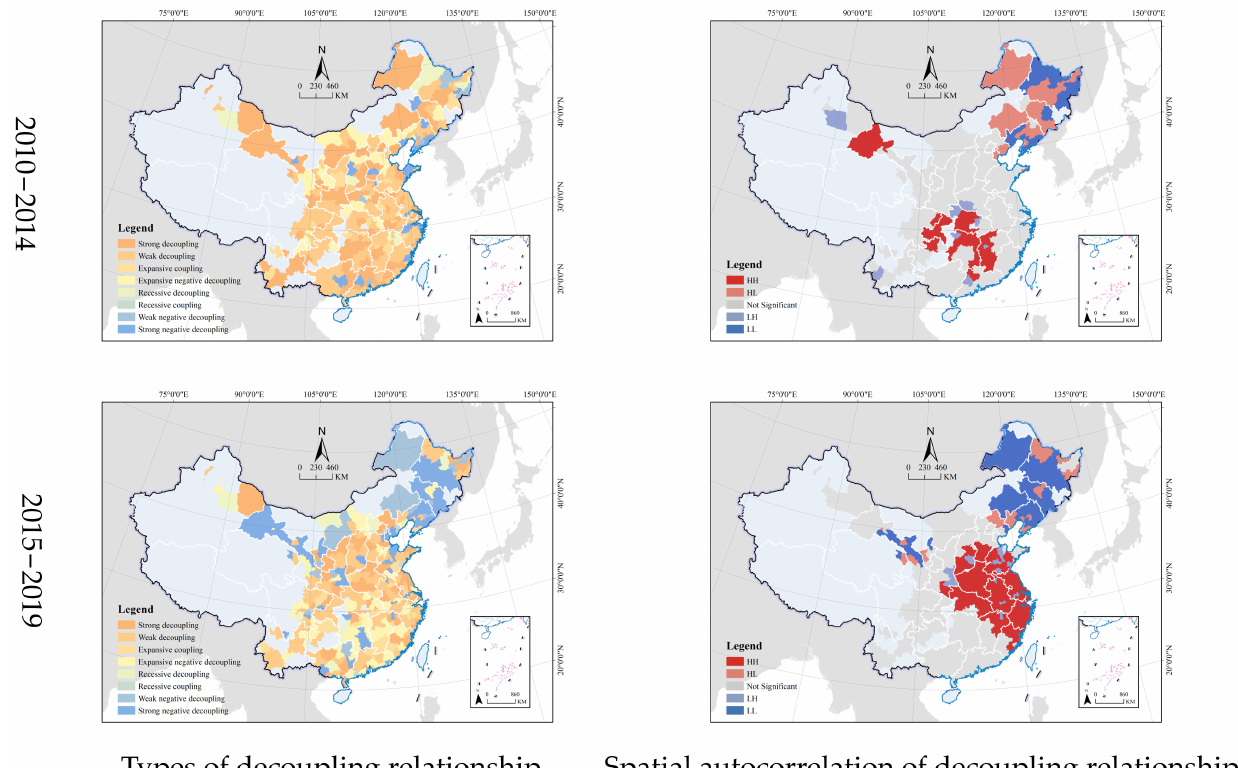
Figure 6. Decoupling type and spatial autocorrelation of industrial land and second-industry added